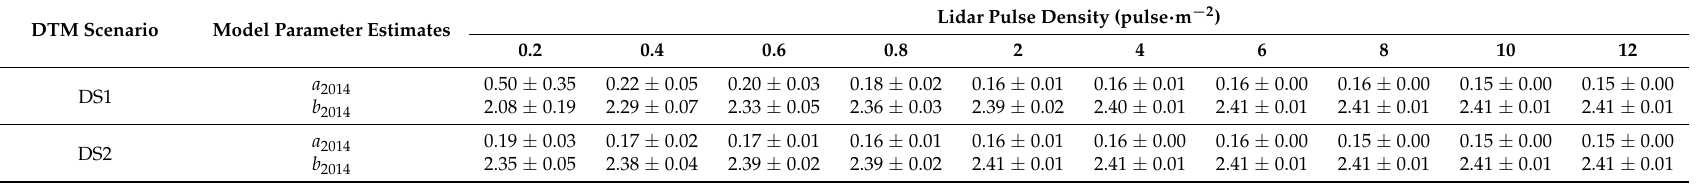
Table 3. Mean and standard deviation of the parameters a 2014 and b 2014 for the AGB models in 2014. DS1: DTM Scenario 1; DS2: DTM Scenario